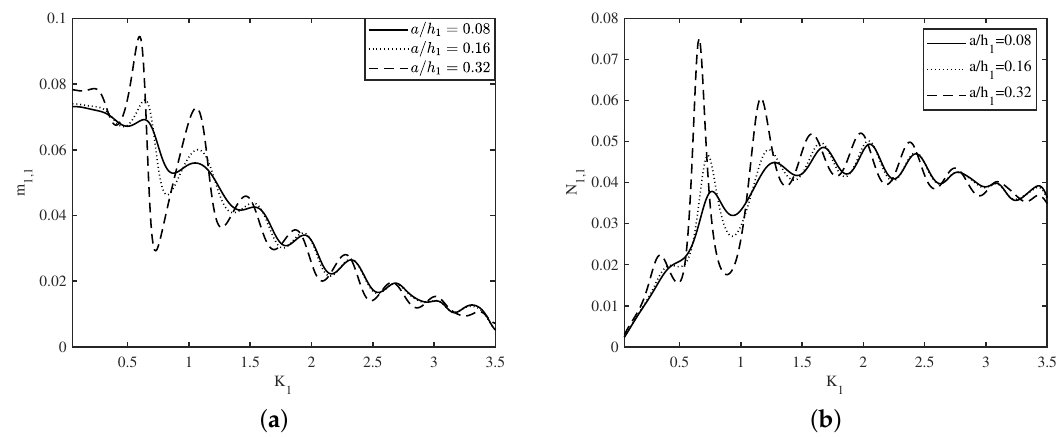
Figure 3. Variation of ( a ) m 1,1 and ( b ) N 1,1 vs K 1 for different a / h 1 . In Figure 3, the variation of (a) the added mass m 1,1 and (b) the damping coefficient N 1,1 corresponding to surge motion are plotted as a function of the non-dimensional frequency parameter K 1 for various values of ripple amplitude a / h 1 of the sinusoidally varying bottom. It is seen that the added mass m 1,1 and damping coefficient N 1,1 vary in an oscillatory manner with the variation in K 1 . Moreover, the oscillation amplitude is higher for 0.5 < K 1 < 1.5. This may happen due to the effect of Bragg resonance around the primary Bragg value K 1 = 1. In addition, the amplitude of the oscillation in the added mass and damping coefficients are larger for higher values of ripple amplitude a / h 1 . Further, Figure 3a shows that the overall trend of the added mass m 1,1 is decreasing in nature as the wavenumber K 1 takes higher values. On the other hand, Figure 3b reveals that the damping coefficient N 1,1 initially increases with an increase in wavenumber K 1 . However, a reverse trend is observed for higher values of the wavenumber K 1 , i.e., in the short wave regime.